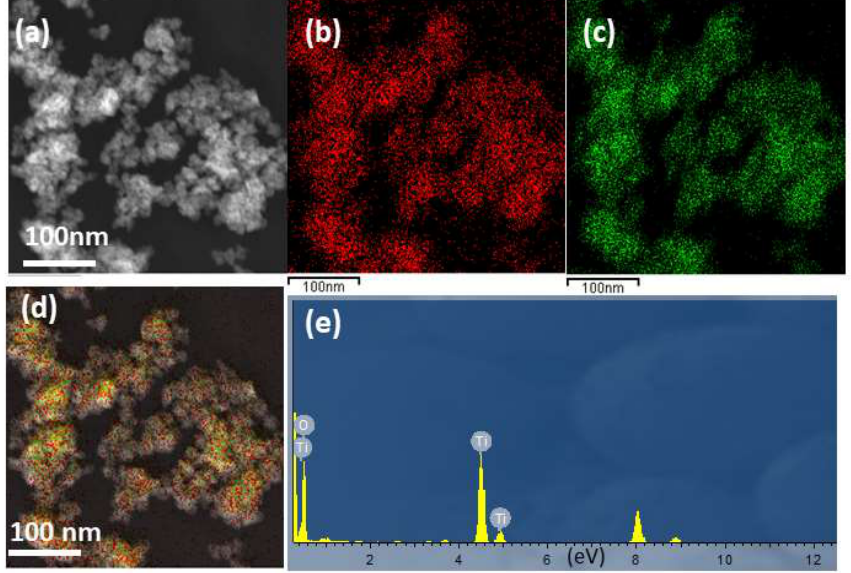
Figure 6. ( a ) TEM image: ( b ) dispersity of O, ( c ) dispersity of Ti, ( d ) elemental mapping of Ti and O, and ( e ) EDX analysis of 5 nm TiO 2 nanocomposites. The atomic percentage for O and Ti was 69.88 and 30.12,